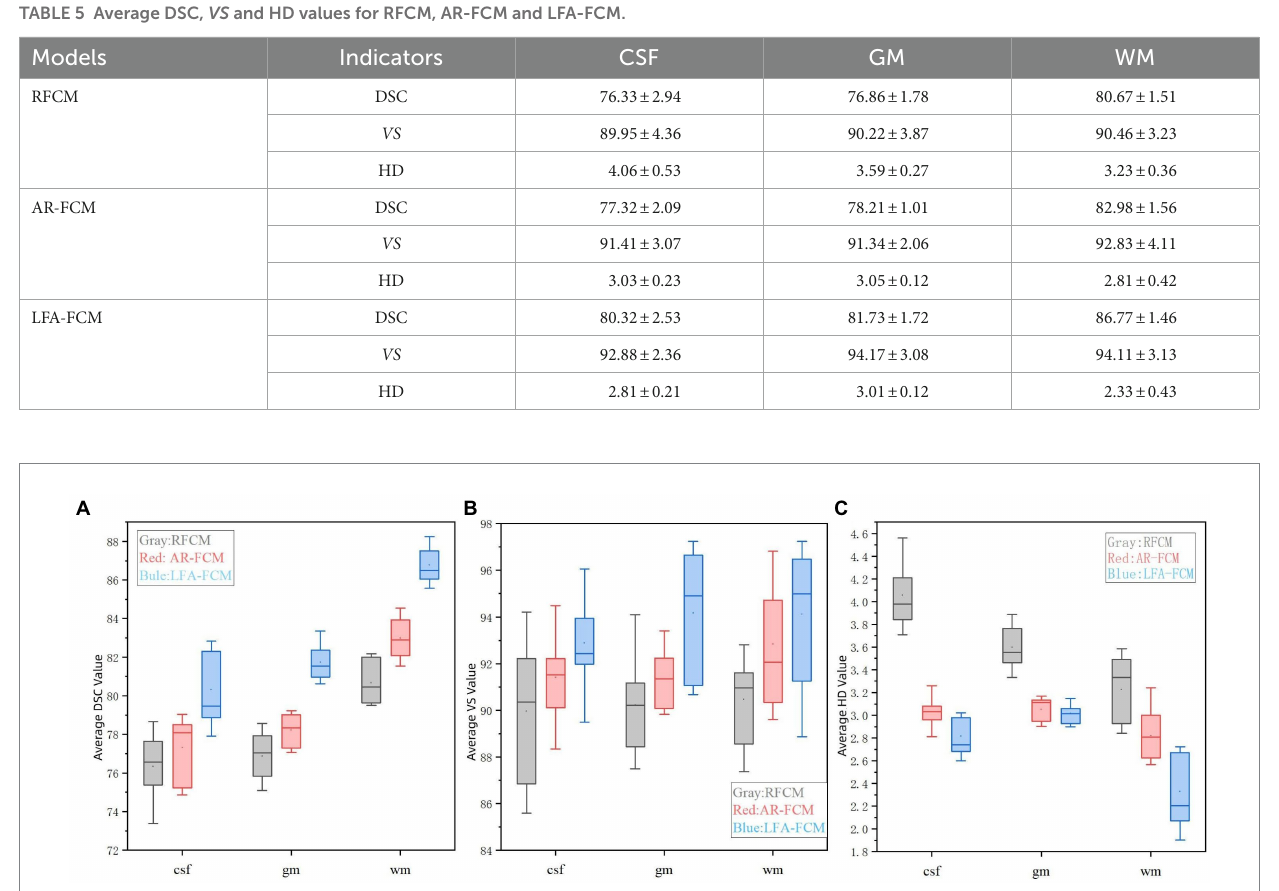
FIGURE 9 Indicator data visualization results. (A) Average DSC values of RFCM, AR-FCM and LFA-FCM, (B) average VS values of RFCM, AR-FCM and LFA-FCM, and (C) average HD values of RFCM, AR-FCM and